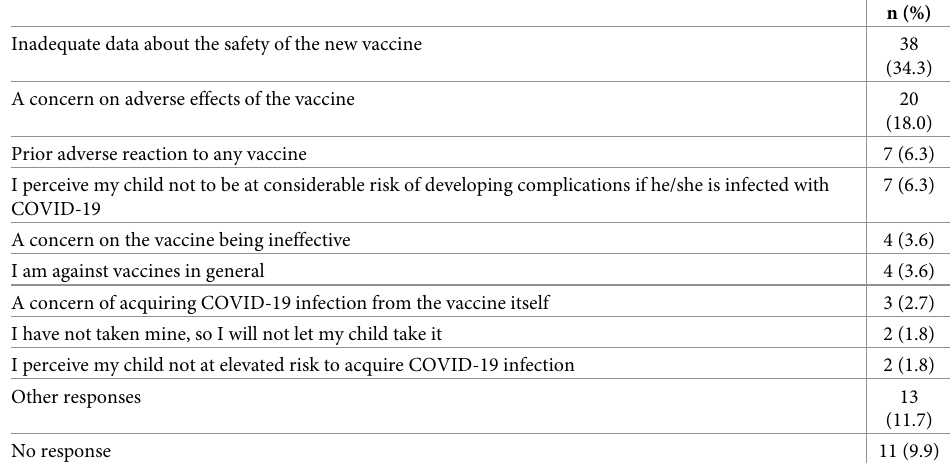
Table 1. Main reason for the non-acceptance of the COVID-19 vaccine for children.